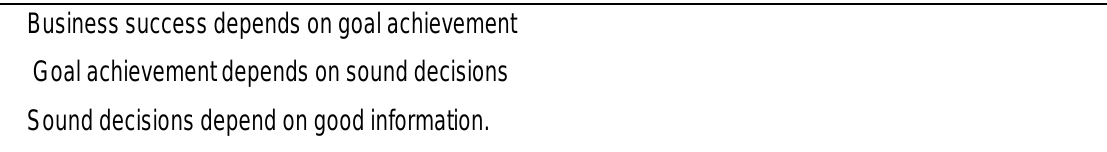
Table 1: The importance of information